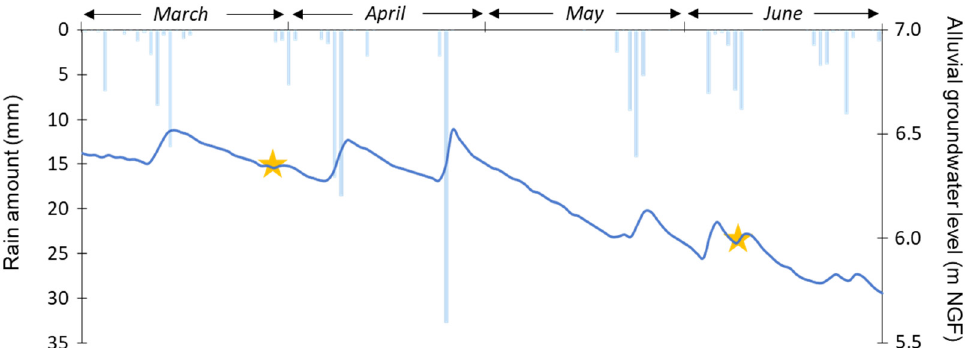
Figure 2. Precipitation (in mm) and alluvial groundwater level (in m NGF, measured at W6) from March to June 2022. The sampling campaigns are indicated by yellow